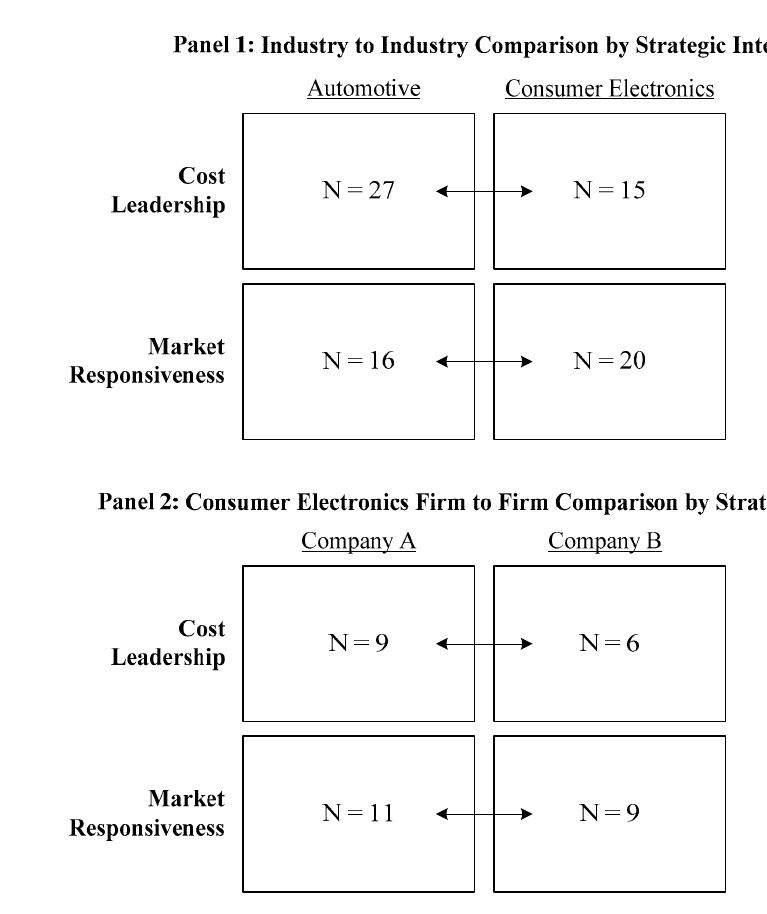
Figure 3. Framework for further investigation.